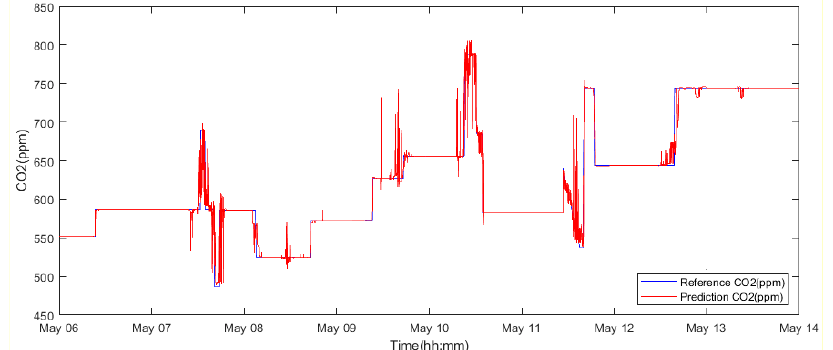
Figure 13. Model number 9 trained and validated using data from the interval of the 6 th of May 2018 to 13 th of May 2018.